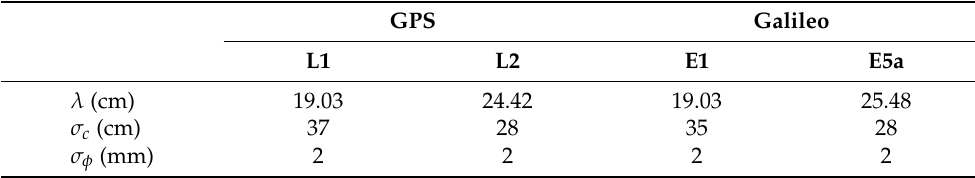
Table 1. Wavelengths and zenith-referenced code and carrier standard deviations for GPS and Galileo observations.